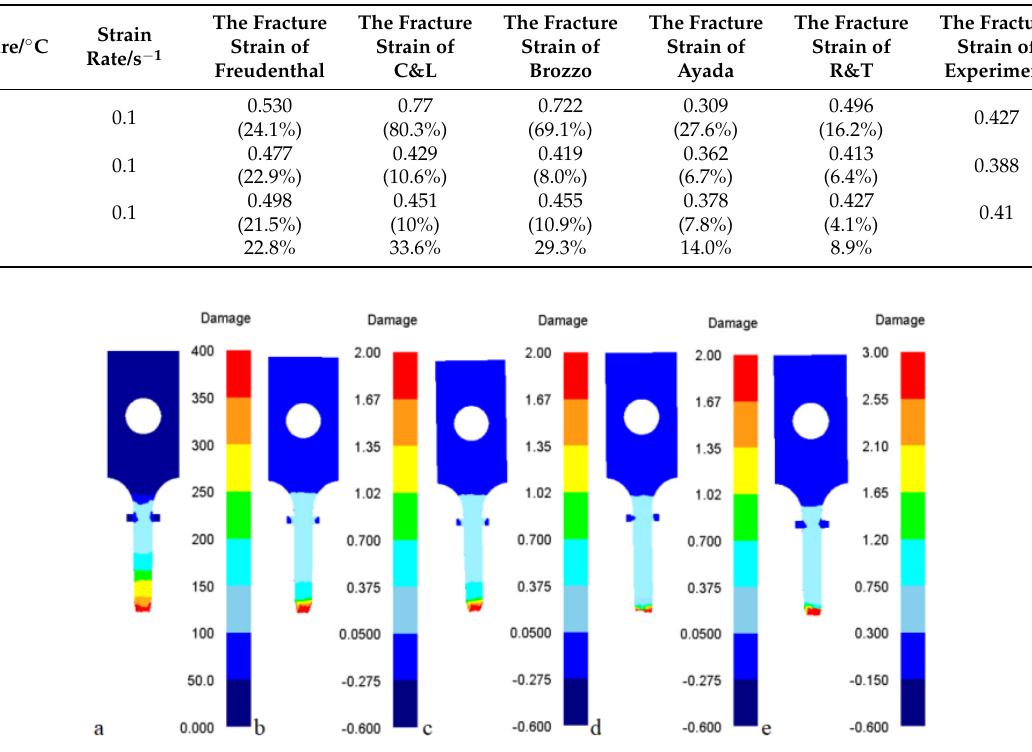
Figure 7. Distributions of the damage values at temperature 600 °C and strain rate 0.1 s − 1 in the tensile test with different criteria at fracture moment: ( a ) Freudenthal model, ( b ) C&L model, ( c ) Brozzo model, ( d ) Ayada model, ( e ) R&T model.